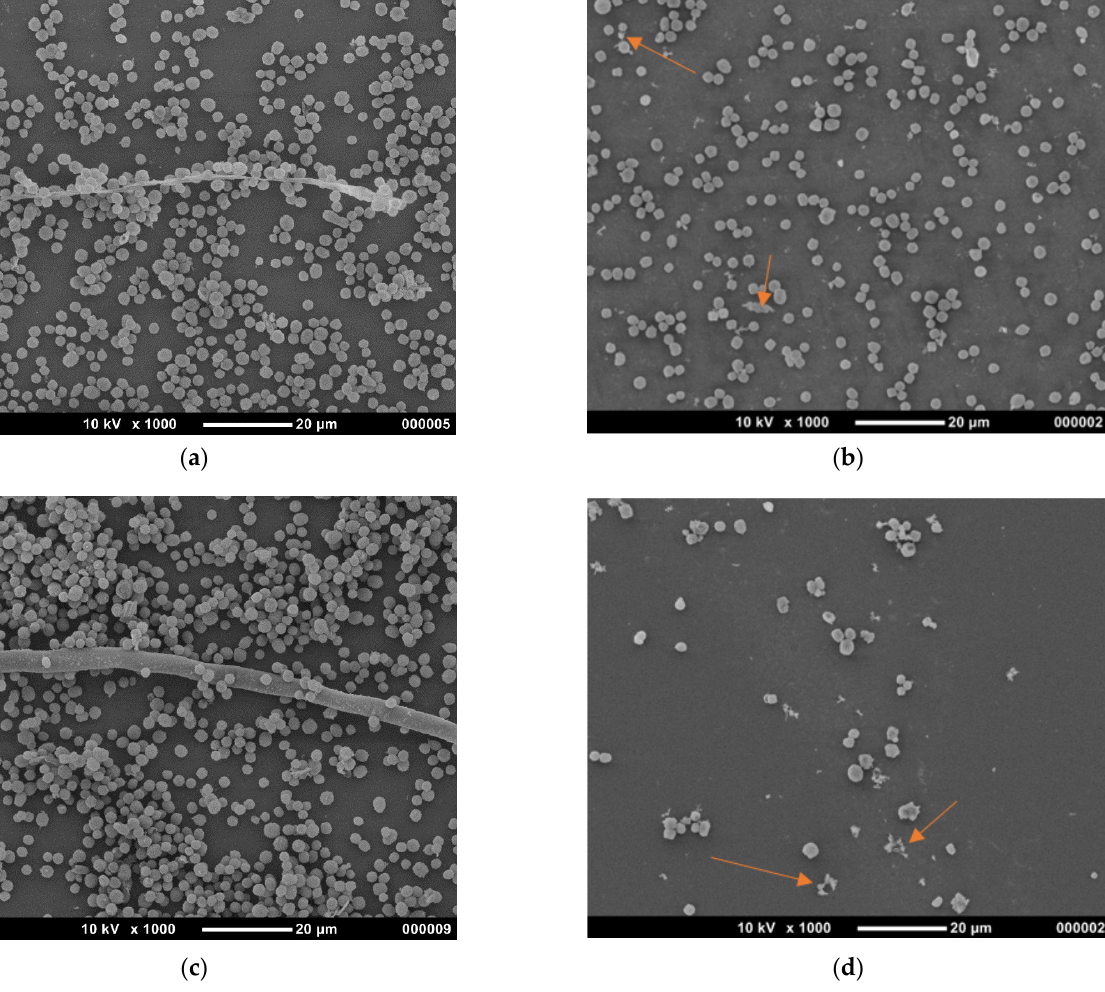
Figure 4. Scanning electron micrographs of Aspergillus flavus spores after different treatments (×1000; scale bar = 20 µm). ( a ) P o L o = control; ( b ) P o L + = light; ( c ) P + L o = photosensitizer; ( d ) P + L + = photosensitization. Arrows in the SEM micrographs indicate cell wall deformation.